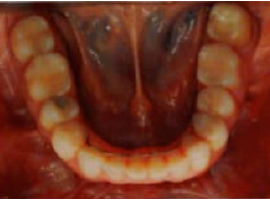
Figure 4. The second left mandibular molar received a root canal treatment despite being vital and